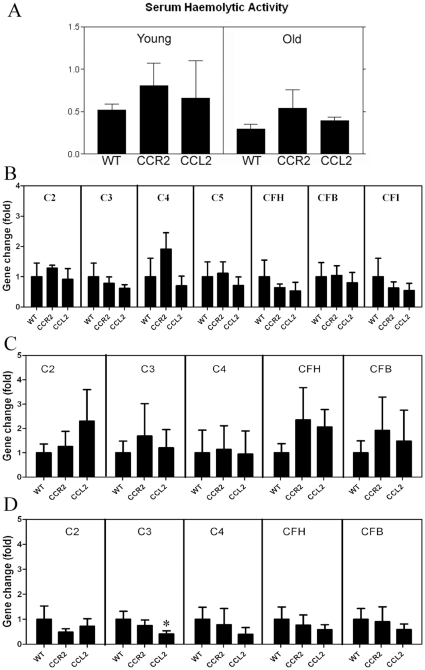
Complement expression in different strains of mice.A, Haemolytic activity of serum from different strains of mice. Mean ± SEM, N = 12 mice. B–D, complement gene expression in the liver (B), retina (C) and RPE/choroid (D) of different strains of 24-month old mice. Results are expressed as relative gene fold change of CCR2 KO or CCL2 KO mice against WT mice. Mean ± SEM, N = 6∼8, *, P<0.05 in comparison to WT mice, Dunnett's multiple comparison test.